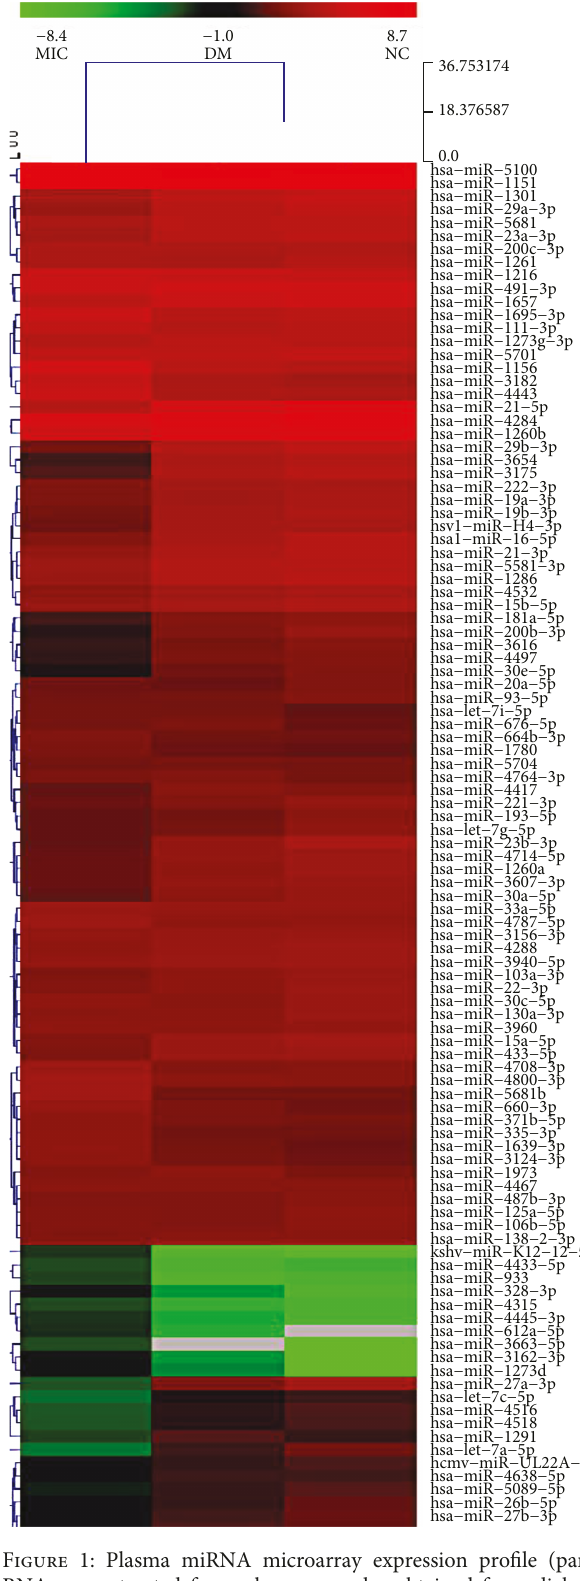
Figure 1: Plasma miRNA microarray expression pro fi le (part). RNA was extracted from plasma samples obtained from diabetic patients with microalbuminuria (Mic, n = 10 ), diabetes mellitus patients with normoalbuminuria (DM, n = 10 ), and normal controls (NC, n = 10